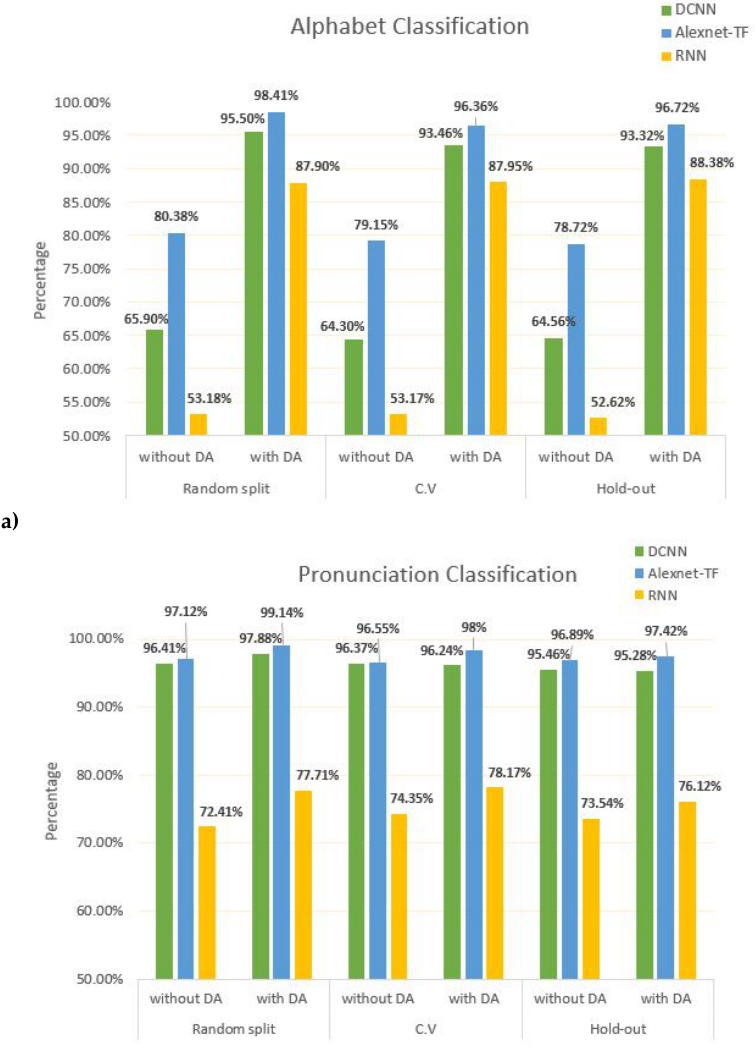
Figure 9. Comparison of DCNN, AlexNet, and BLSTM models with and without data augmentation using different validation strategies. ( a ) Alphabet classification. ( b ) Pronunciation